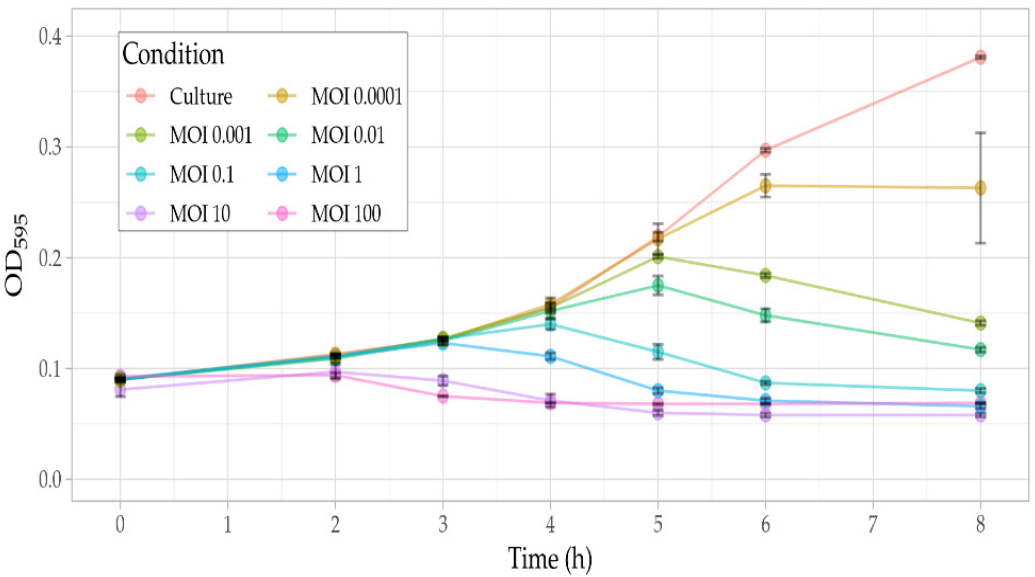
Figure 5. Kill curves of phage Ps15 at different MOIs showing progressive lysis of the host S. maltophilia AP143S in TSB at 37 °C. Growth inhibition was assessed against the non-infected bacterial culture used as a control. The plotted values are averaged from six replicate OD 595 measurements. Error bars indicate the standard deviation of the replicates.